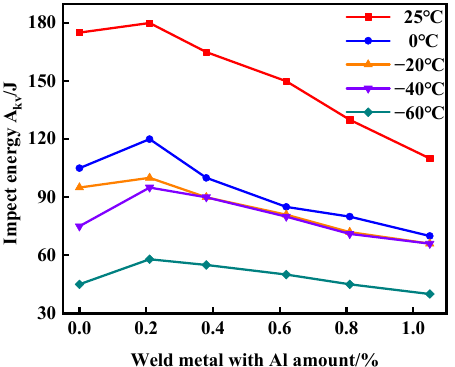
Figure 9. Effect of Al content on impact energy of weld metal.